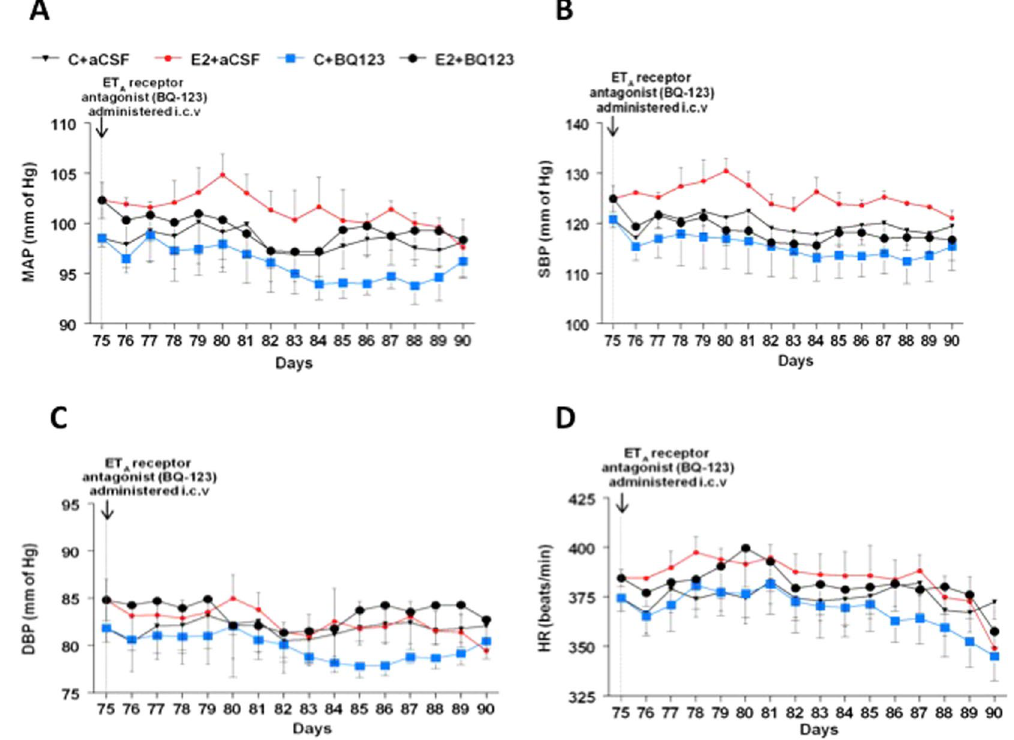
Figure 5. Effect of ICV ET A antagonist on chronic E2-induced increase in MAP. ( A – D ): Line graphs depicting MAP (mmHg), systolic blood pressure (SBP), diastolic blood pressure (DBP; mmHg) and heart rate (HR; beats/ min) respectively: closed circles in red represent E2 pellet implanted (20 ng/day, 90-day slow-release pellets) treated with aCSF (E2 + aCSF) and closed triangles represent control SD rats treated with aCSF (C + aCSF), Blue squares represent control rats treated with ET A antagonist (BQ-123) (C + BQ-123) and closed circles in black represent E